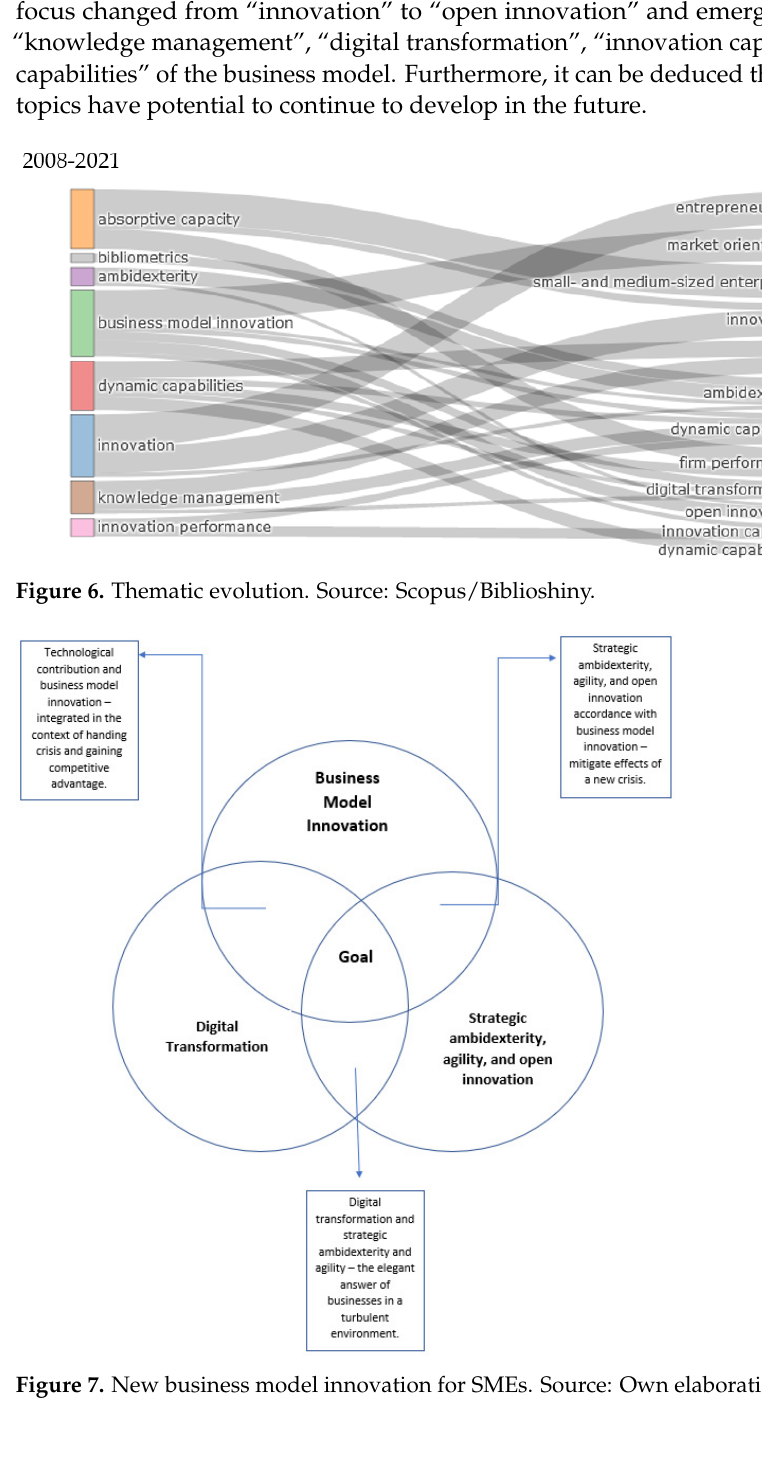
Figure 7 . New business model innovation for SMEs. Source: Own elaboration.